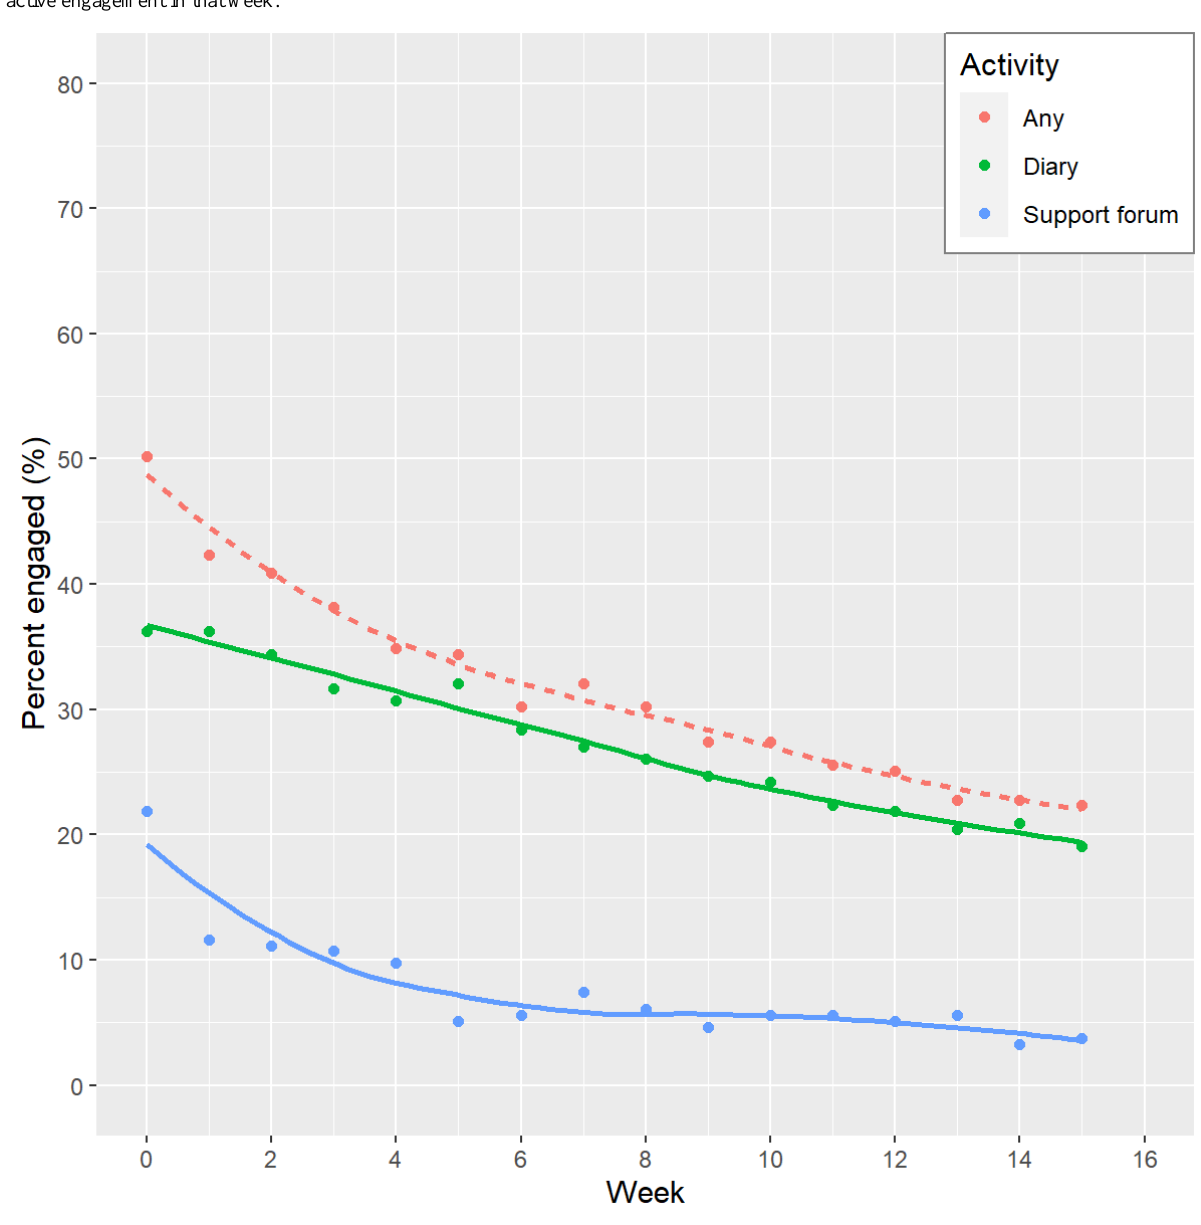
Figure 3. Trends in engagement by week according to type of activity (diary, online peer support forum). “Any” activity represents percentage with any active engagement in that